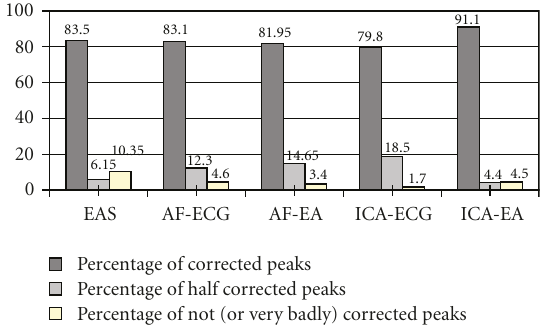
Figure 16: Global correction rates of the five processes computes on the 10 excerpts (2000 interference